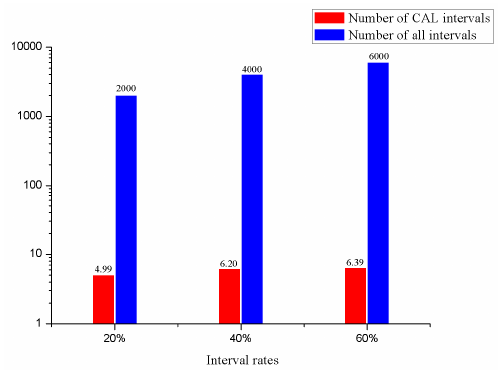
Figure 12. Average of CAL Intervals of Different Interval Rates.